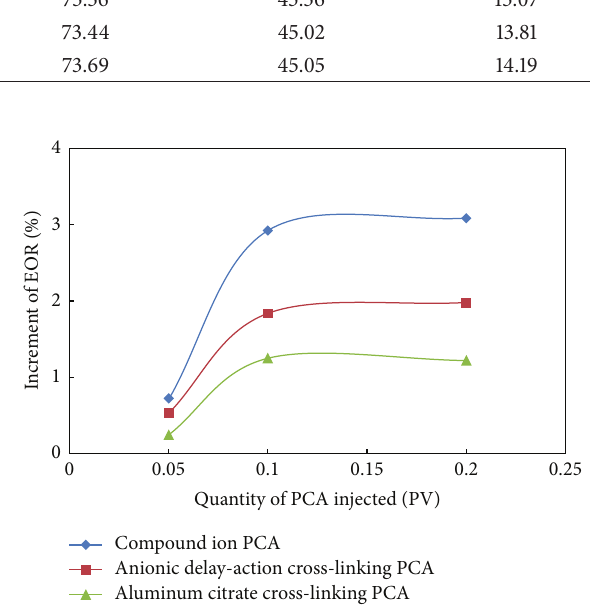
Figure 1: The relation between injected PV of PCA and recovery increment before polymer flooding.